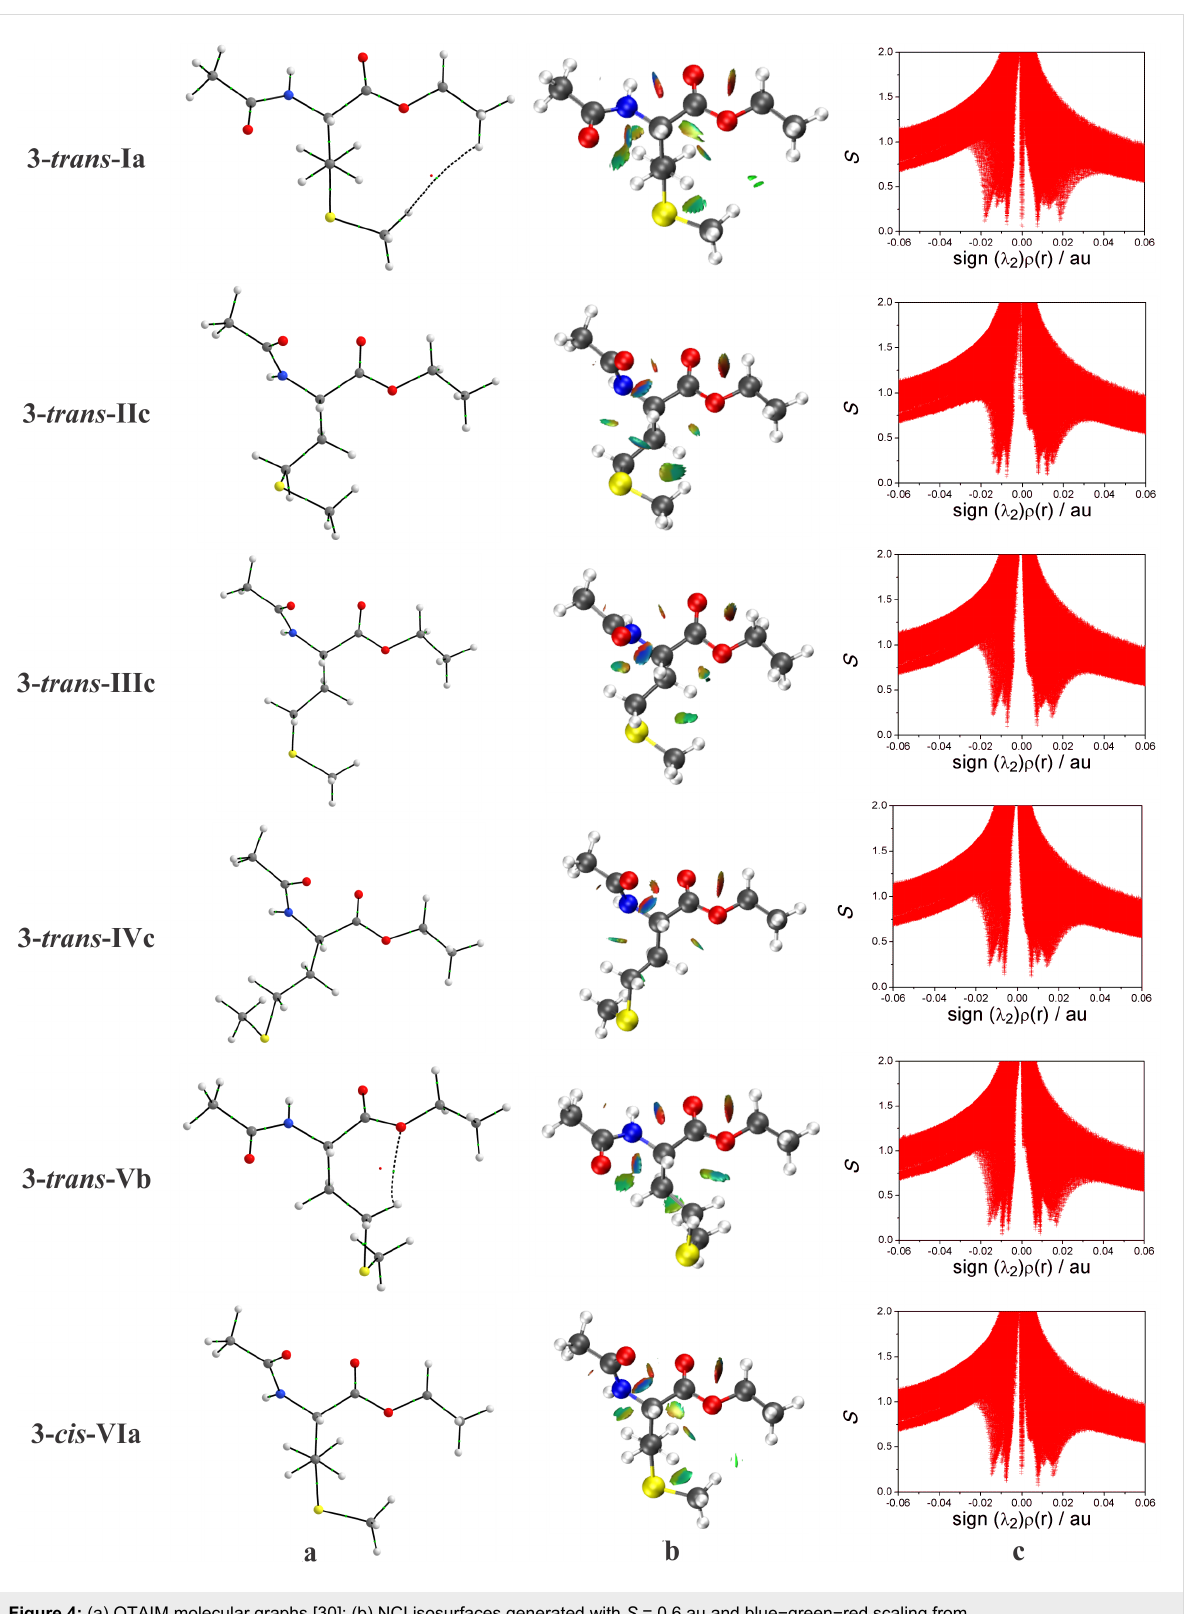
Figure 4: (a) QTAIM molecular graphs [30]; (b) NCI isosurfaces generated with S = 0.6 au and blue − green − red scaling from − 0.02 < ( λ 2 ) ρ (r) < 0.02 au, and (c) NCI plots of the reduced density gradients S versus sign ( λ 2 ) ρ (r) for the conformers of 3